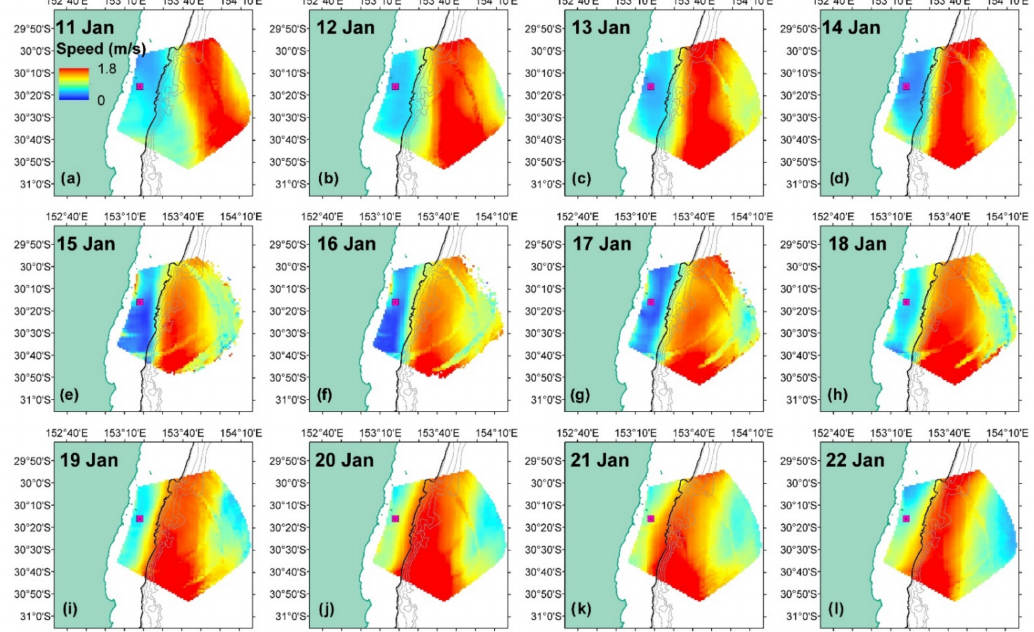
Figure 2. Daily averaged surface current speed from 11–22 January 2016 ( a – l ) observed by HF radar. The line and point symbols are as in Figure 1. The black line denotes the shelf break.